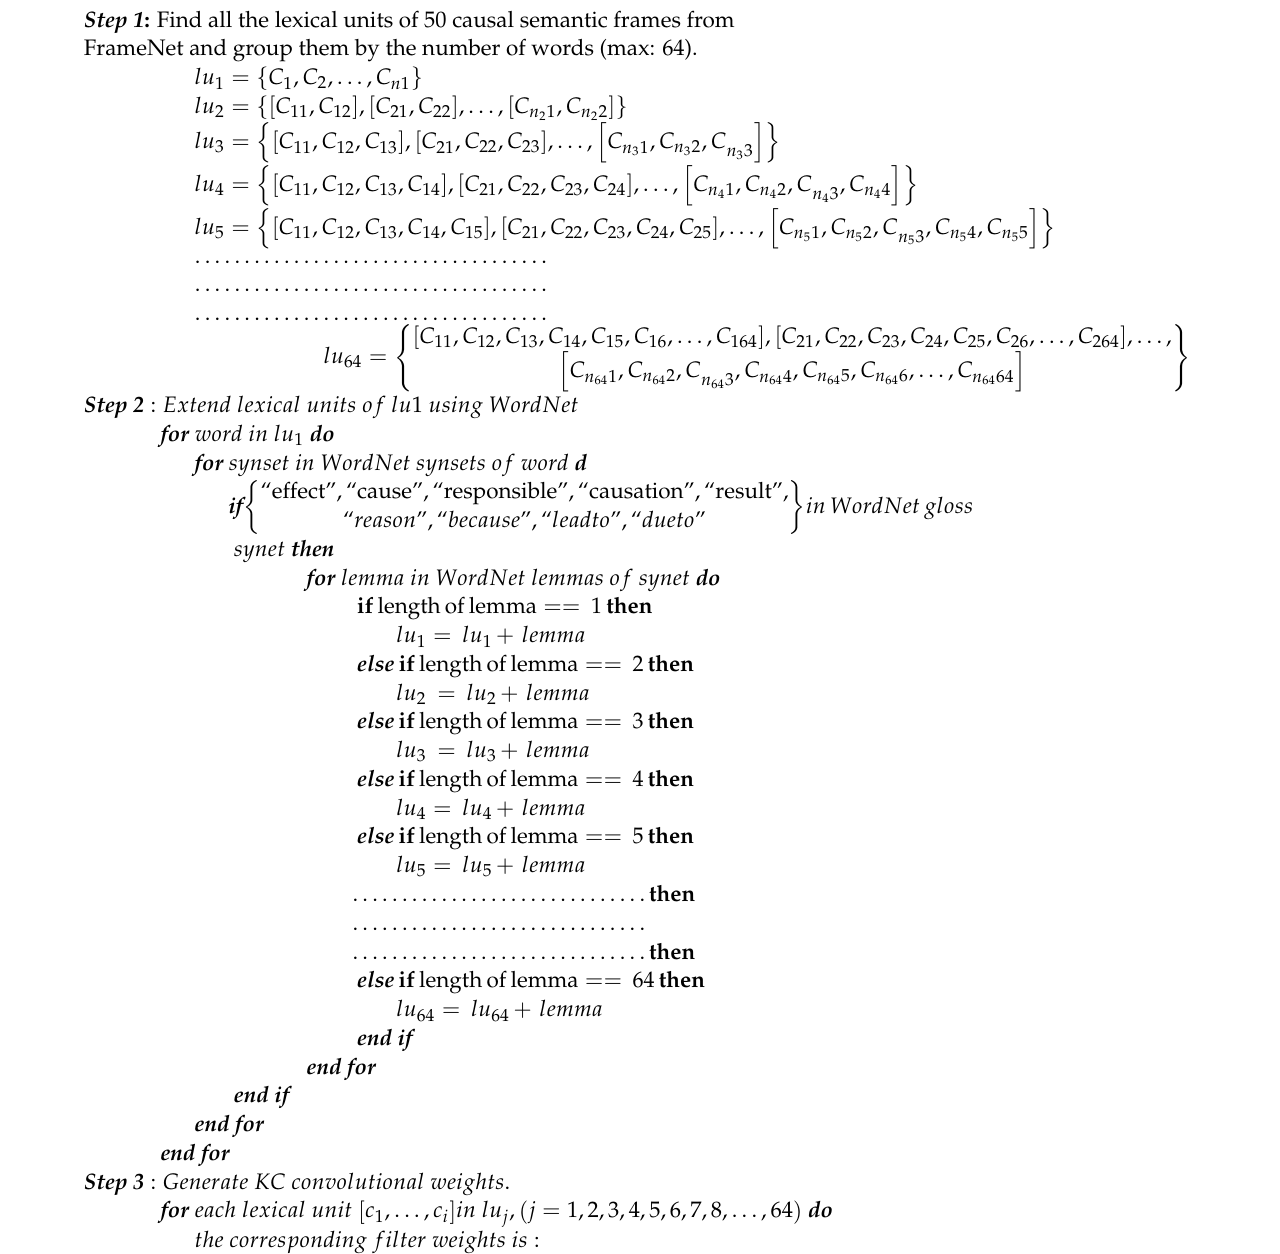
Algorithm 1: Automatic word filters’